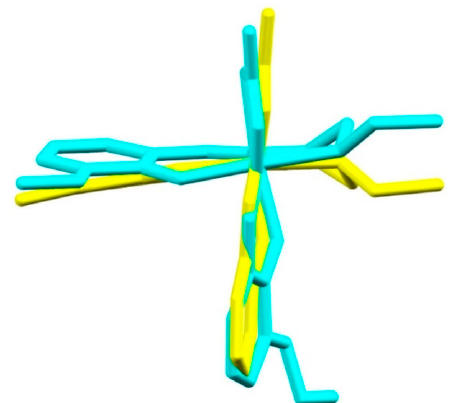
Figure 2. Superimposition of the Fe(III) molecules of 1 (yellow) and 2 (cyan) in a “wireframe”